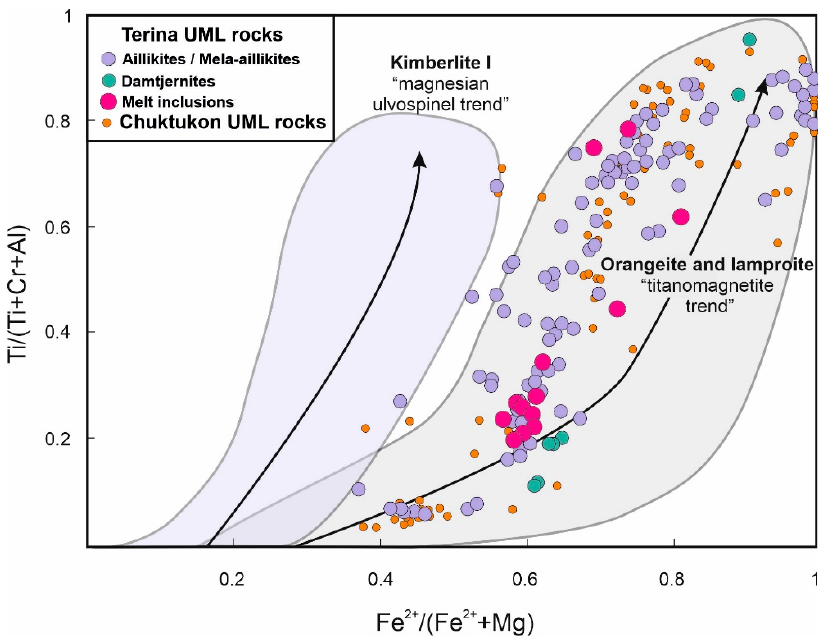
Figure 3. Atomic Ti / (Ti + Cr + Al) vs. Fe 2 + / (Fe 2 + + Mg) plot for the spinel-group minerals of the Terina Figure 3 . Atomic Ti/(Ti + Cr + Al) vs. Fe 2+ /(Fe 2+ + Mg) plot for the spinel-group minerals of the Terina and Chuktukon [7] UML rocks. Kimberlite and orangeite trends are taken from and Chuktukon [7] UML rocks. Kimberlite and orangeite trends are taken from [33].